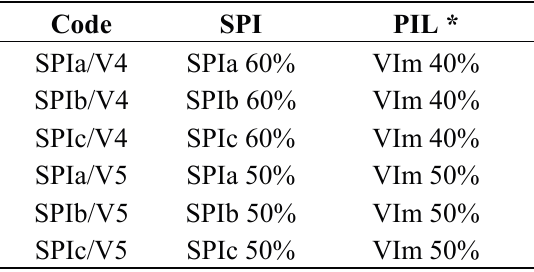
Table 2. Codes and weight compositions of sulfonated polyimide/ionic liquid (SPI/IL) composite